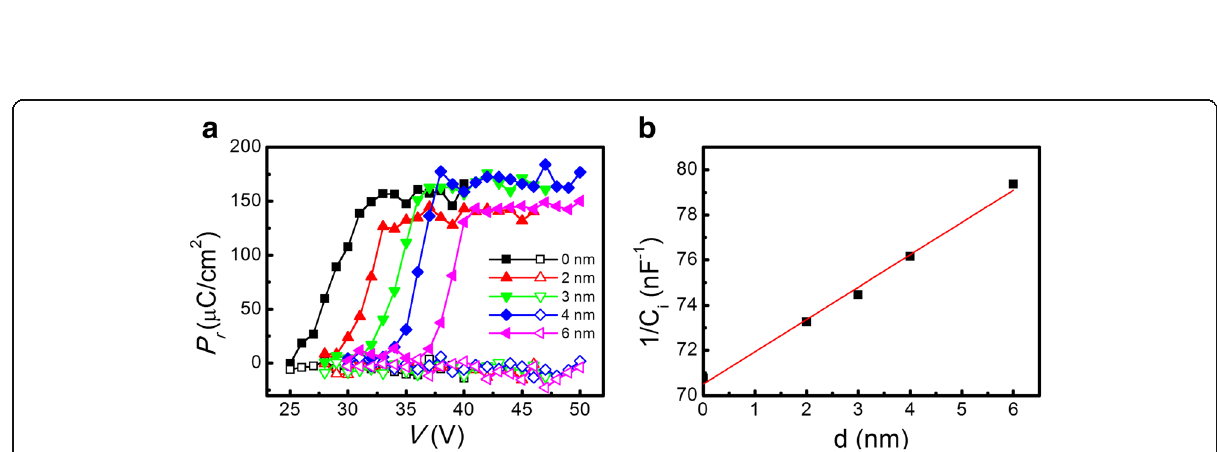
Fig. 4 a The switching ( P sw ) and nonswitching ( P nsw ) polarizations versus V with d increased from 0 to 6 nm under pulses in type I mode. b The Al 2 O 3 -layer-thickness d dependence of 1/ C tot measured by an impedance analyzer at 100